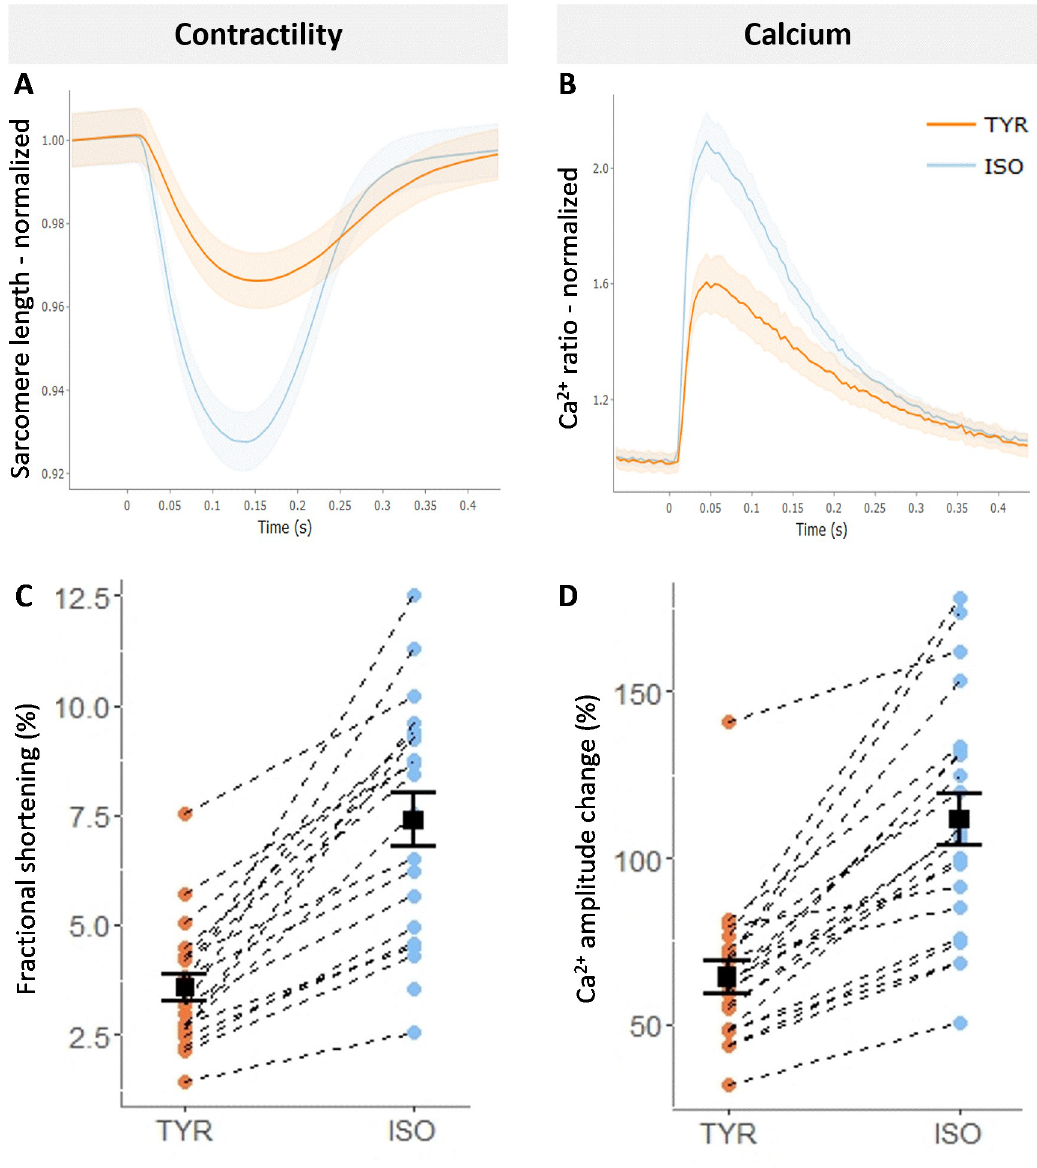
Fig 5. Results isoprenaline (30nM) experiment. A . Average contractility trace before and after isoprenaline (ISO, n = 21) shaded area indicates the 95% confidence interval. B . Average calcium trace before and after ISO (n = 21). C. Fractional shortening of each cell before and after ISO. D. Calcium amplitude change of each cell before and after ISO